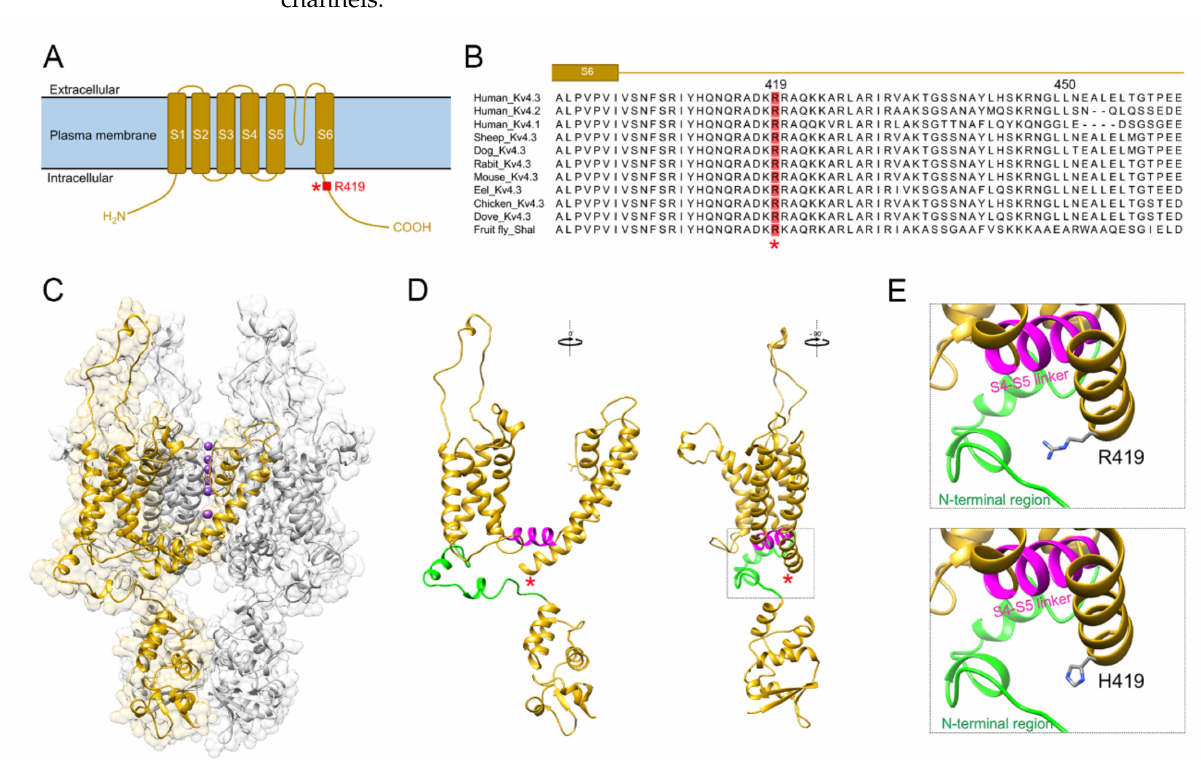
Figure 2. Protein structure modeling of human K V 4.3 WT and the p.R419H variant. ( A ) Schematic representation of the membrane topology of a single K V 4.3 subunit, highlighting the cytoplasmic localization of the residue p.R419 in the proximal carboxyl-terminal region close to the S6 transmembrane segment. ( B ) Amino acid sequence alignment of human K V 4.3 with various K V 4-related proteins from multiple animal species. The highly conserved p.R419 residue is decorated in red and marked with an asterisk. ( C – E ) Homology model of K V 4.3 was based on the crystal structure of the voltage-dependent K + channel K V 1.2 (PBD ID: 3LUT) and generated using UCSF Chimera interfaced with Modeller. ( C ) Tetrameric structure of the K V 4.3 channel. One K V 4.3 monomer is displayed as ribbon in gold, with the other subunits in gray. The shadow refers to the surface representation of the homology model. Purple spheres denote K + passing through the pore region. ( D ) ( Left panel ) The single K V 4.3 subunit in gold in ( C ) is shown here. ( Right panel ) The same K V 4.3 subunit is viewed with 90-degree rotation clockwise. The red asterisk highlights the location of the residue p.R419. The S4-S5 linker is shown as magenta helix, and a portion of the amino (N)-terminal region is colored in green. The area enclosed by dotted lines in the right panel is enlarged for inspection in ( E ). ( E ) Comparison of the side-chain structure of the p.R419 WT and the p.H419 variant with respect to the local